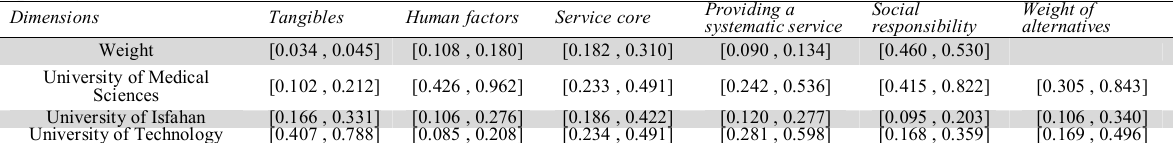
Calculation of final weight of performance for each higher education institution based on their service